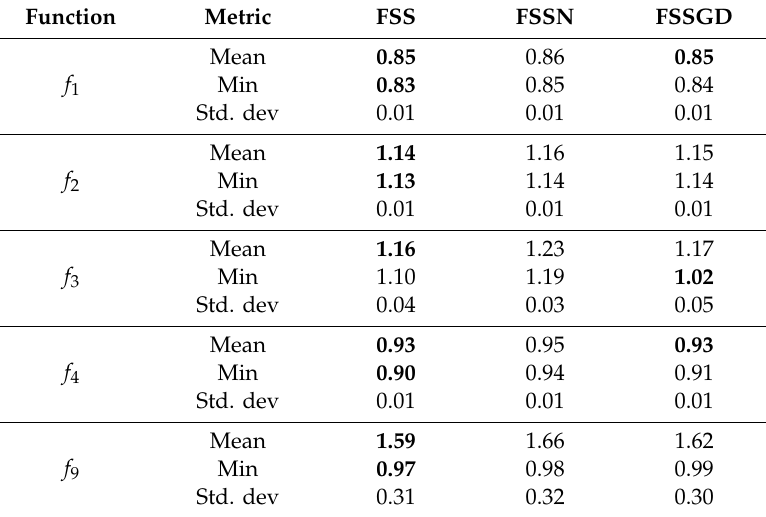
Table 4. Time benchmarks of 5-dimensional test functions listed in Table